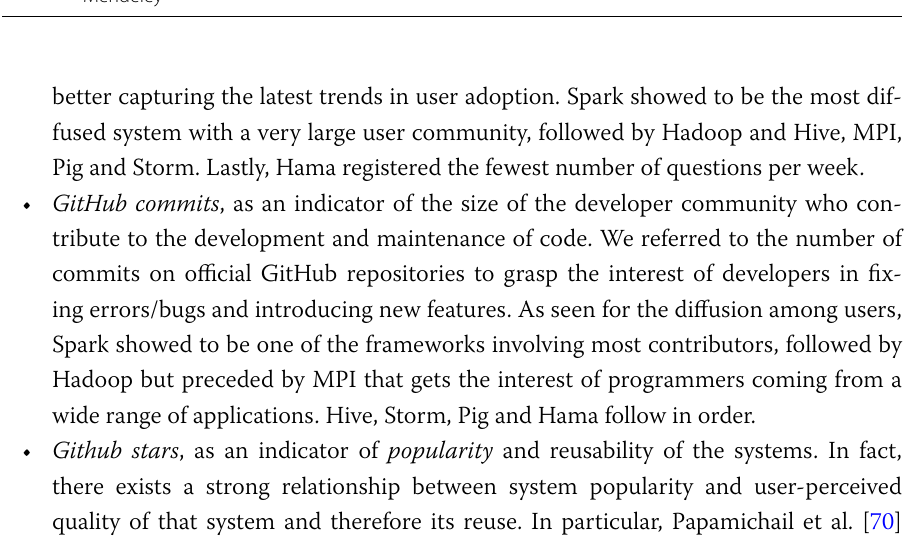
Table 3 Advantages and disadvantages of the systems System Advantages